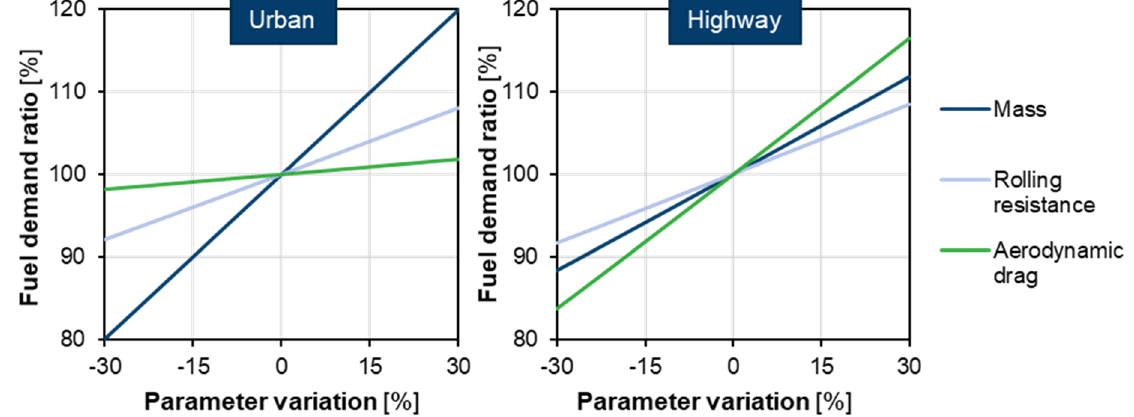
Figure 10. Effects of parameter variation on fuel demand for BEVs for urban ( left ) and highway ( right ) driving scenarios.